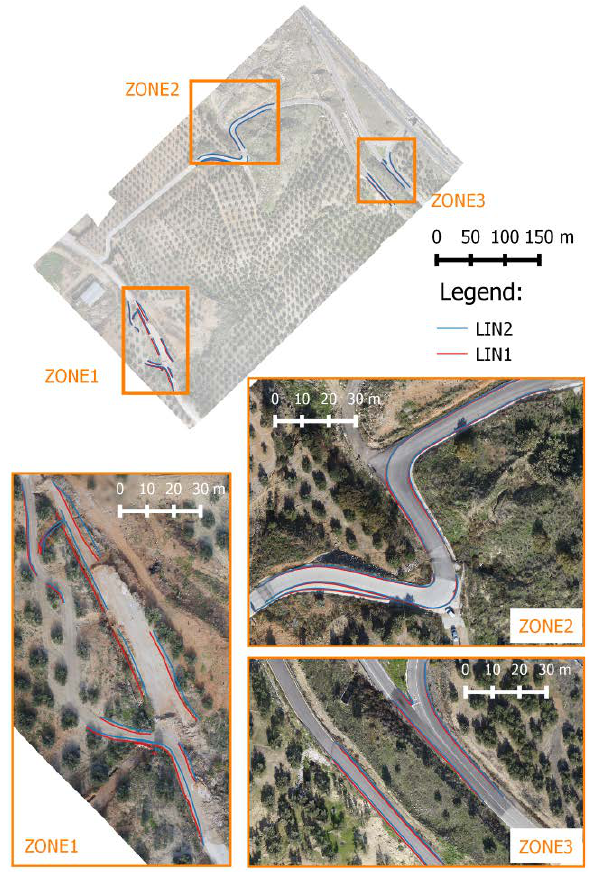
Figure 4. Datasets LIN1 and LIN2 of digitized lines over ORTHO1. Division by zones.